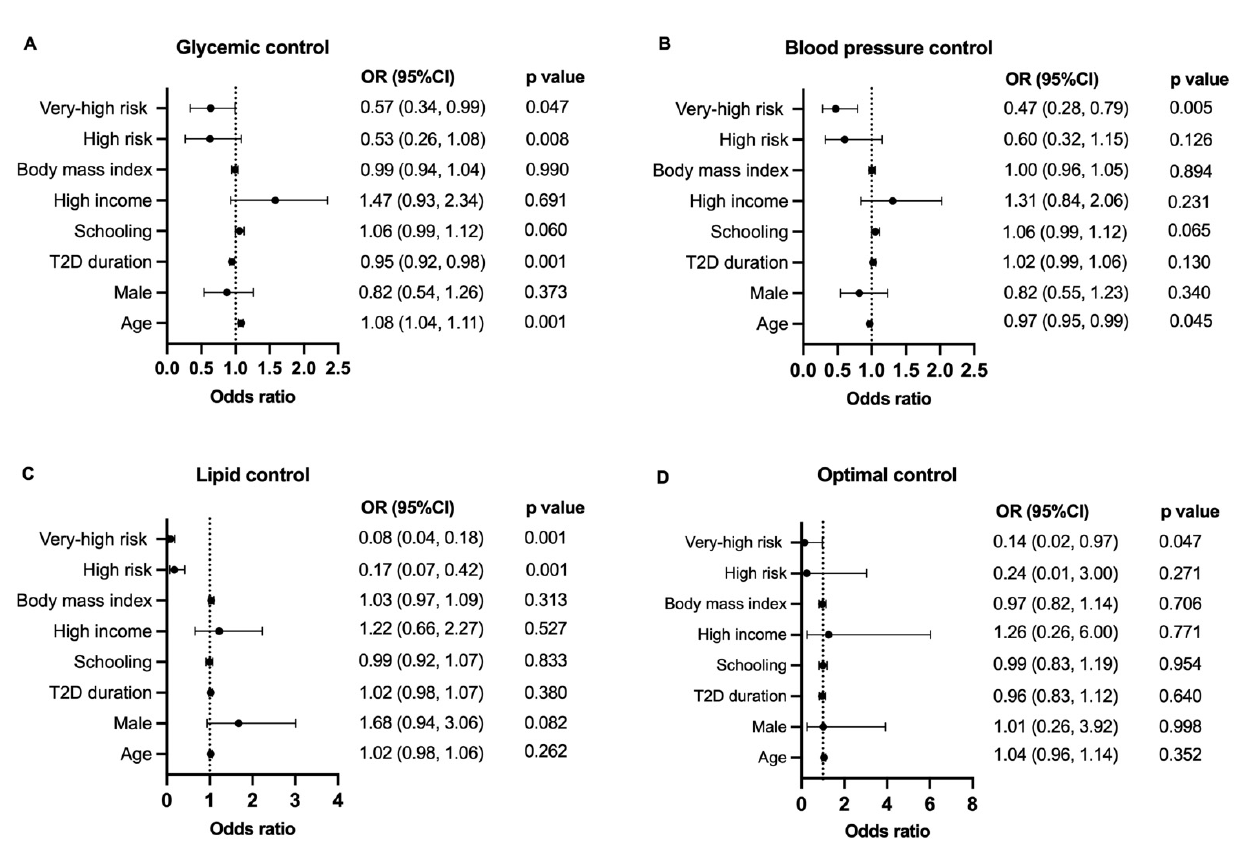
Figure 2. Forest plot presenting the result of adjusted logistic regression analysis for target achievement ( A ) A1c, ( B ) SBP, ( C ) LDL-C, ( D ) all three targets. Forest plot figures for logistic